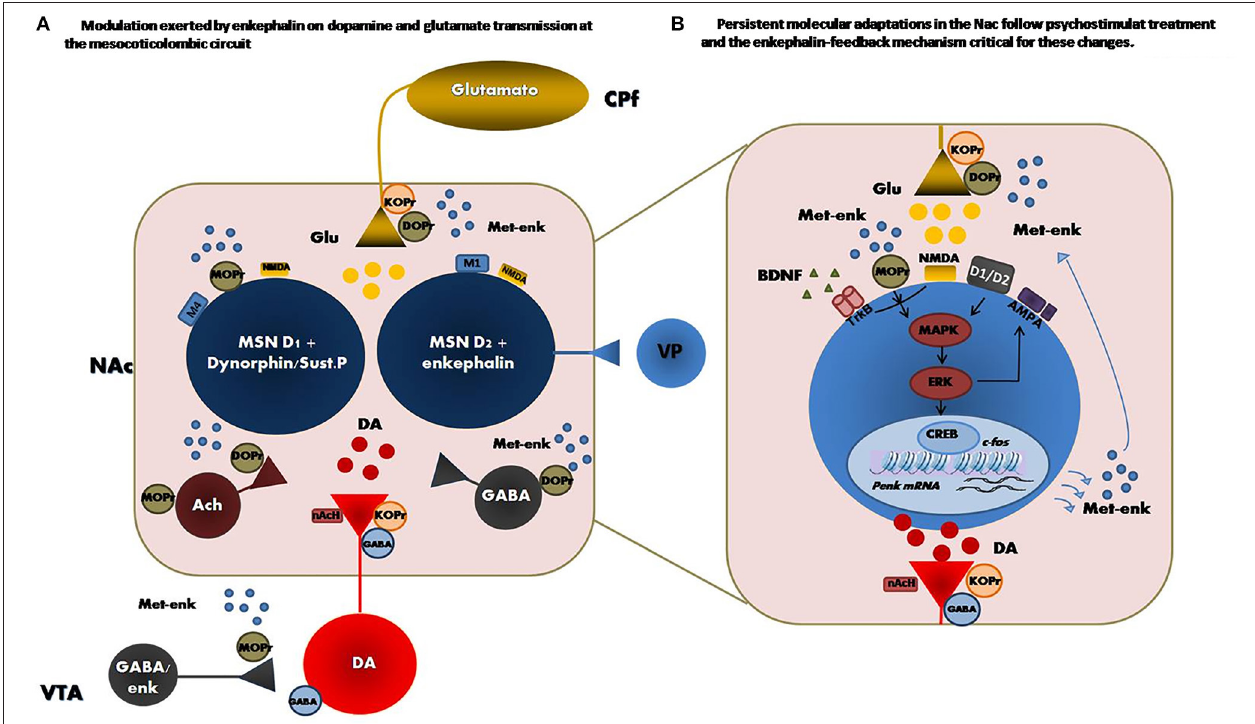
FIGURE 1 | (Left) Principal met-enkephalin target nucleus in the mesocorticolimbic circuit. Distribution of opioid receptors within the circuit network is also shown and reveals the modulation exerted by enkephalin on dopamine and glutamate transmission at this level. (Right) Persistent adaptations in the enkephalin content followed by psychostimulant treatment and the subsequent activation of MOPr could result in a feedback mechanism critical for the neuronal plasticity induced by these drugs in the NAc. Enkephalin transmission activation promotes the development of psychostimulant-induced long-term neurochemical and molecular changes in the NAc, such as increases in BDNF/TrkB, phospho-ERK2/CREB signaling activation and GluR1 AMPA cell surface expression. VP, ventral pallidum; VTA, ventral tegmentalarea; PfC, Prefrontal cortex; DA, dopamine; Ach, acetylcholine; Glu, glutamate; met-enk, methionine encephalin; GABA, γ -aminobutyric, M1 and